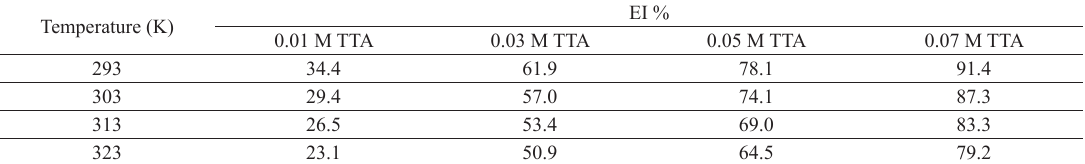
Table 2. Corrosion efficiency results of mild steel in 0.5 M HCl solution with different concentrations of TTA (0.01 to 0.07 M) at various temperatures (293, 303, 313 and 323 K). Temperature (K)